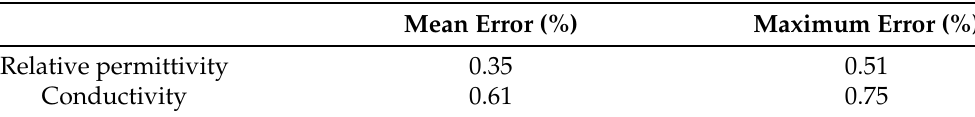
Table 4. The mean and the maximum value of the fit error in percentage. Error values for fit of each part of the heart ( n = 6) of each heart ( n = 4) measurements are calculated as the mean value across all frequency points. The mean error is the mean across all parts of each of the hearts. The maximum error is the maximum across all parts of each of the